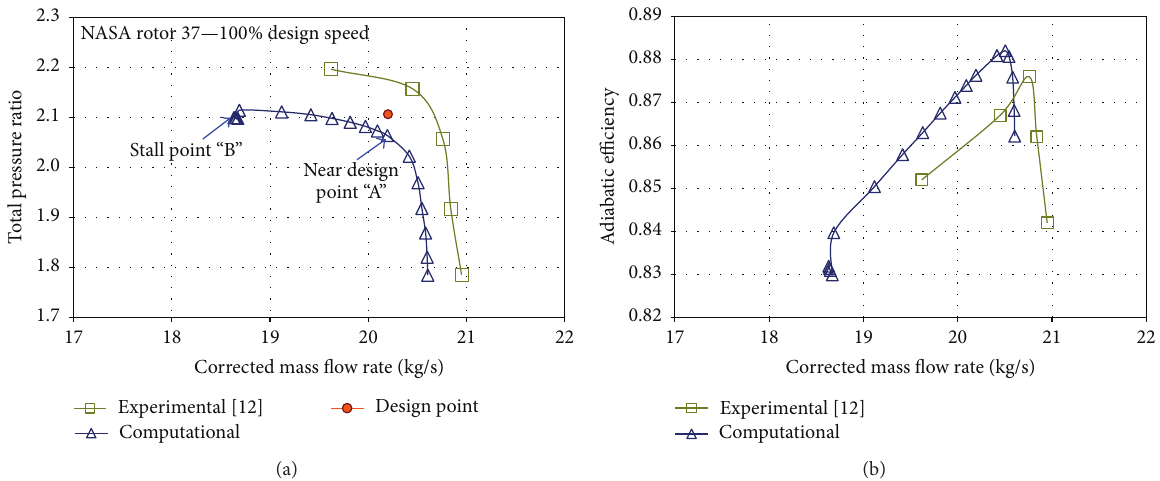
Figure 7: Predicted performance characteristics of baseline compressor at 100% design rotational speed and comparison with experimental data of [12].